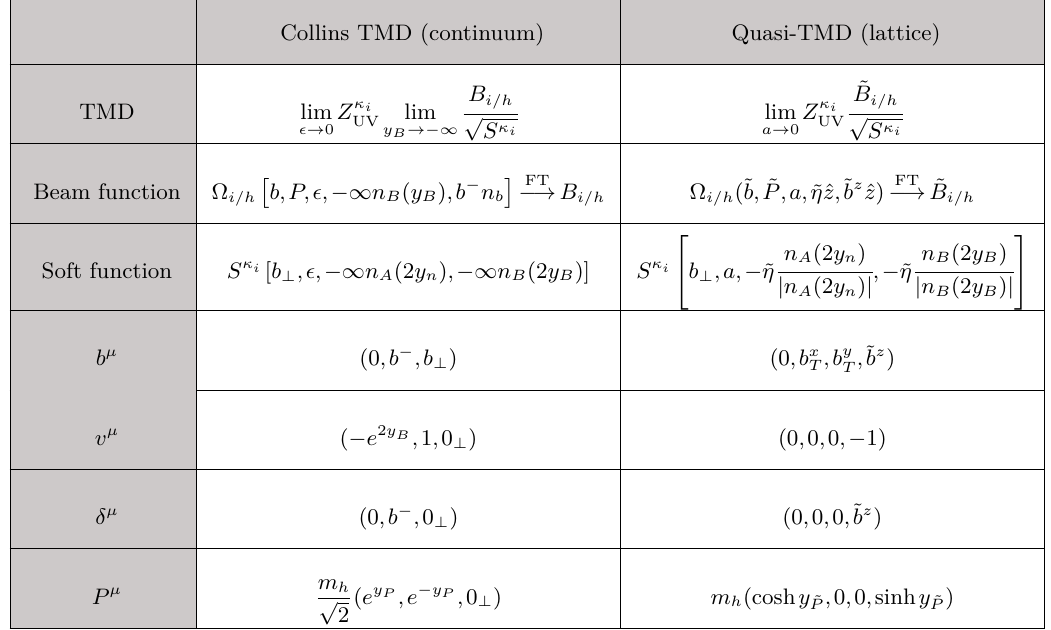
Table 1. Definition of the Collins and quasi-TMDs for quarks and gluons. The Large Rapidity and Collins TMDs are identical, except for the order of the limits and expression for Z κ i